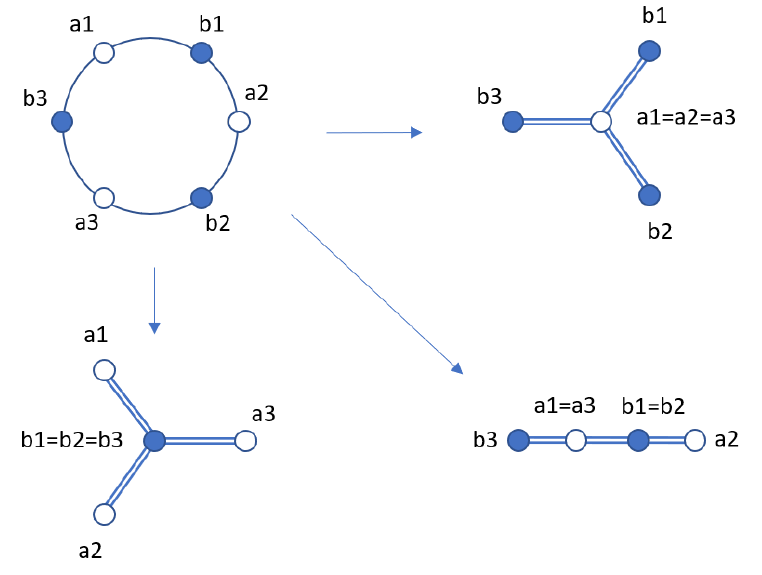
Figure 1 . All the n = 3 graphs at leading order in large- d